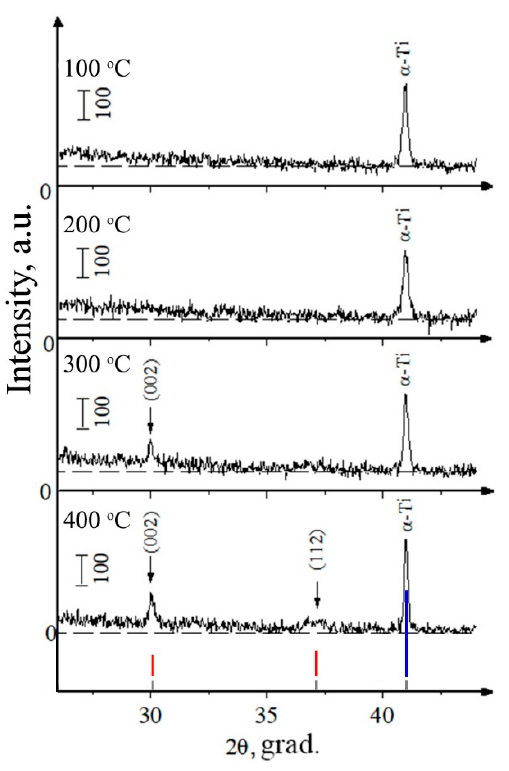
Figure 16. XRD of CaP coating formed at substrate temperatures of 100, 200, 300, and 400 °C. Crystallographic planes are marked for the HA phase (red, blue, and gray lines represent HA (red) and Ti (blue) etalon XRD patterns according to PDF-card no. 00-009-0432 and 00-044-1294, respectively).